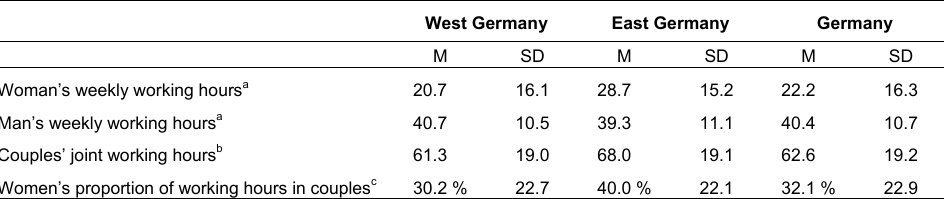
Weekly working hours and women’s share of working time, by